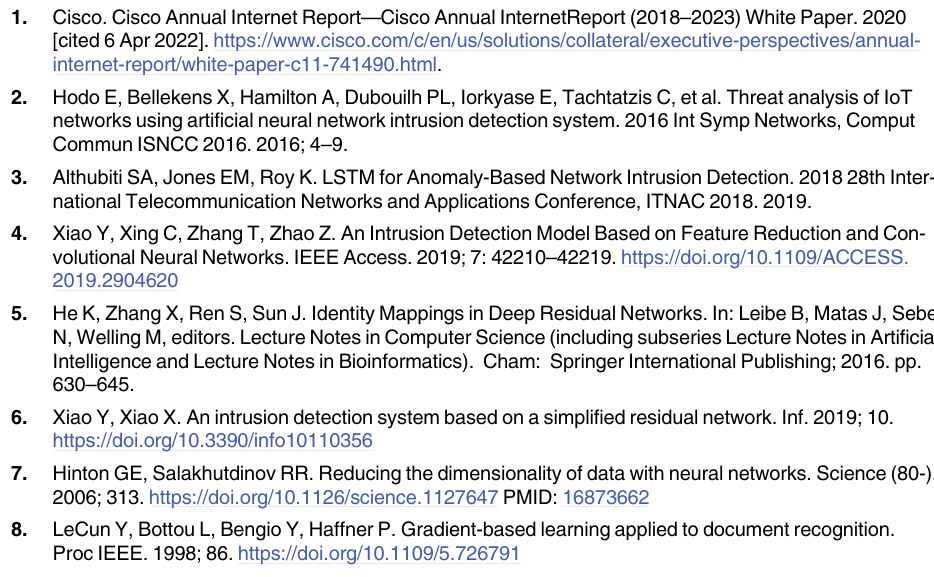
S1 Fig. Correlation matrix between attributes of NSL-KDD dataset. (PNG) S1 Table. The generated rules with four attributes of modified ANFIS. (DOCX) S2 Table. Correlation degree of 41 attributes towards